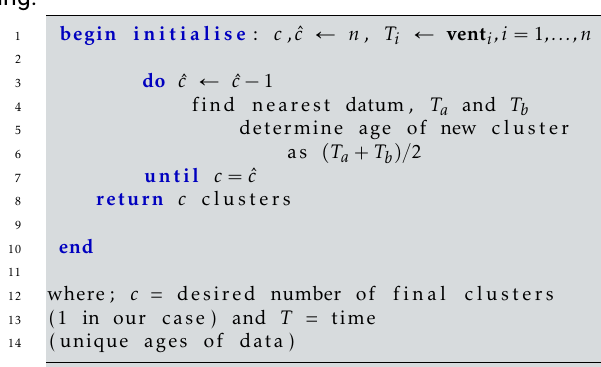
Figure 6: Events (squares) modelled from the synthetic vent data (circles) shown in Figure 4. The black line shows the alignment that was identified and used to model the event that sits along it. Please note that the variation in shading among the constituent vents in the modelled events indicates that not all vents within a cluster need be the same exact age, just close in age (relative age differences are also shown as separation on the Y-axis in Figure